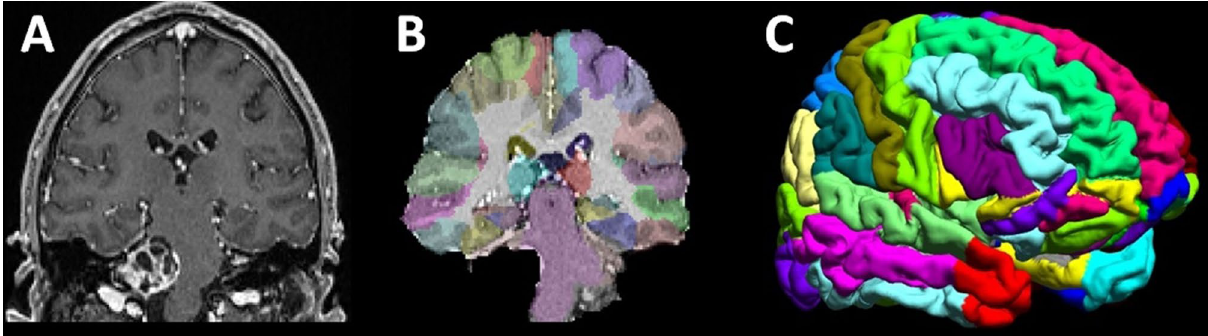
Figure 5. (A) Exemplary MR image of a patient with a T3 vestibular schwannoma of the right side. Data processing included skull striping and brain extraction process followed by the automated brain atlas registration (B,C)